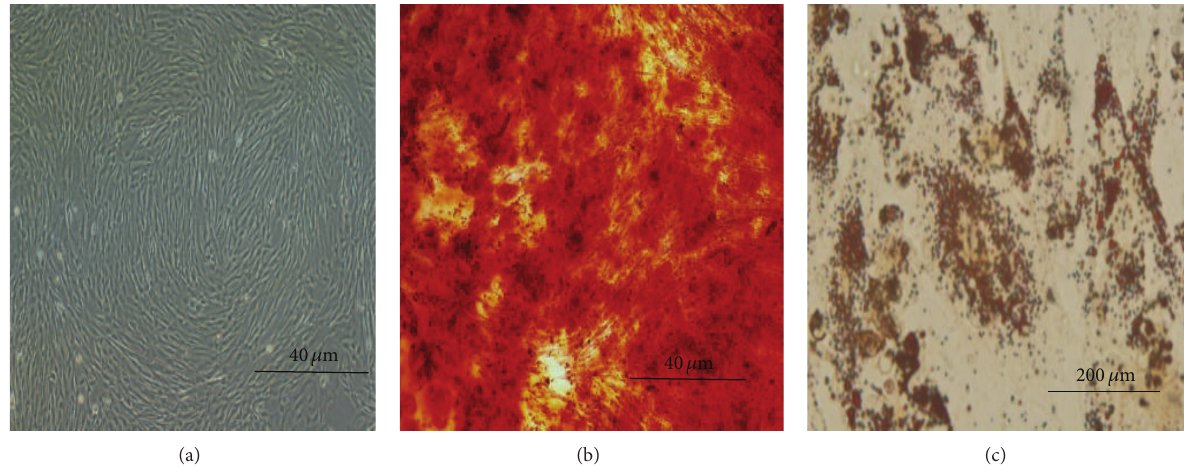
Figure 1: The characteristics of UC-MSCs. (a) Morphology of UC-MSCs; (b) the osteogenic differentiation of UC-MSCs; (c) adipogenic differentiation of